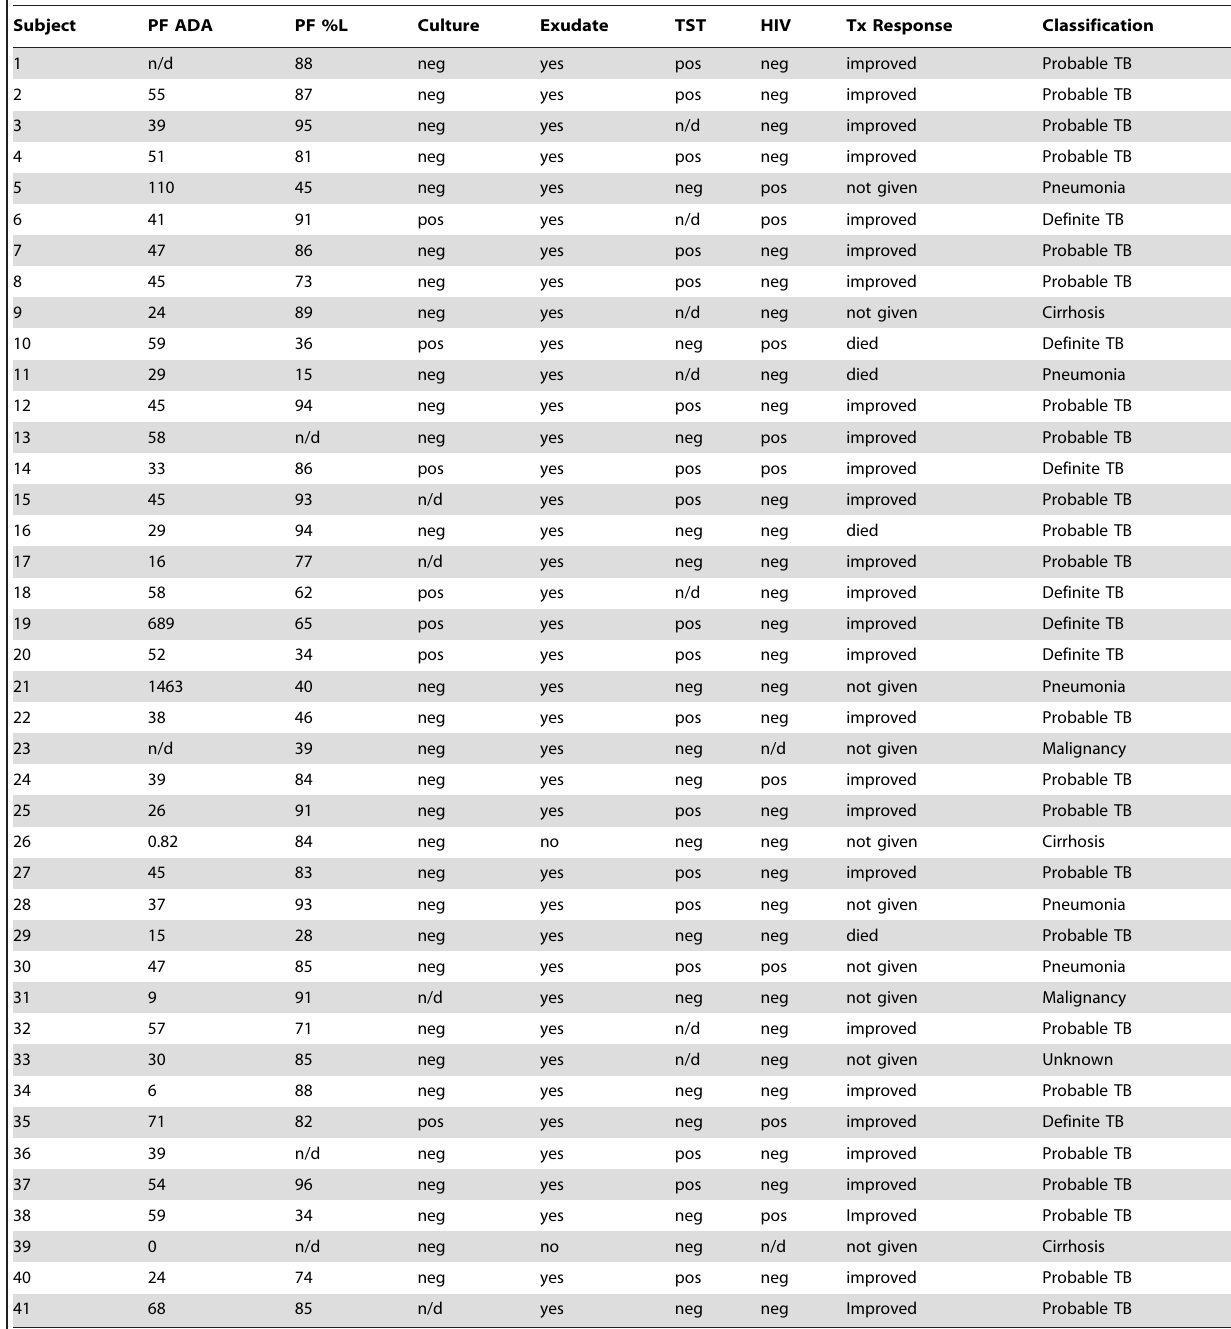
Table 1. Subject information and